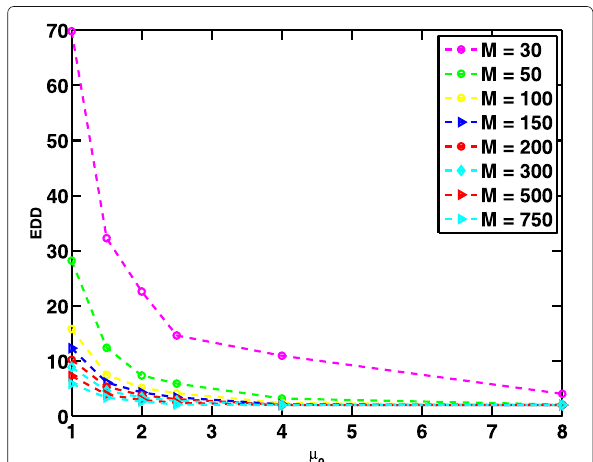
Fig. 14 Power system example: A being a power network topology constrained sensing matrix. The standard deviation of each point is less than half of the value. EDD versus μ 0 when we randomly select 5% edges with mean shift μ